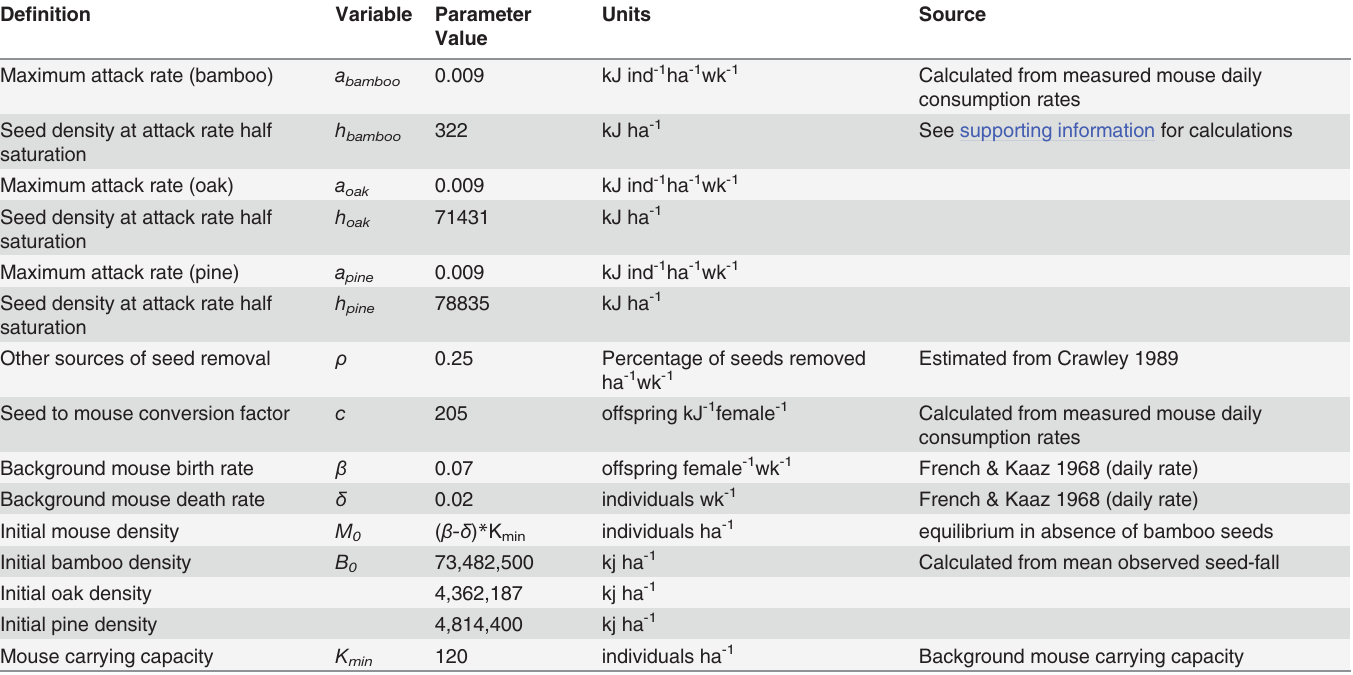
Table 1. Model parameter variables and